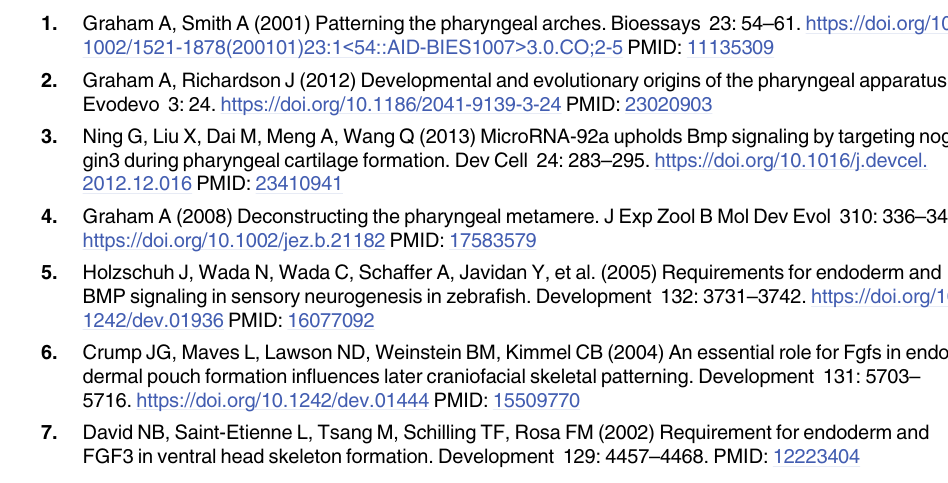
S8 Fig. Endoderm formation is not affected in swr ta72 mutants. The sox17 expression in swr ta72 embryos at the bud stage. The swr ta72 mutant embryos can be easily recognized owing to their elongated shape. Note that the swr ta72 mutants showed nearly normal endoderm speci- fication but delayed convergence of endodermal cells. S9 Fig. An integrated model for the specification of pouch progenitors by ectoderm- derived BMP2b. During the early somite stages, the ectodermal cells (orange) express and secret BMP2b proteins (yellow), which play an essential role in the specification of pouch pro- genitors (pink) from adjacent pharyngeal endoderm (green). PPP, pharyngeal pouch progeni-